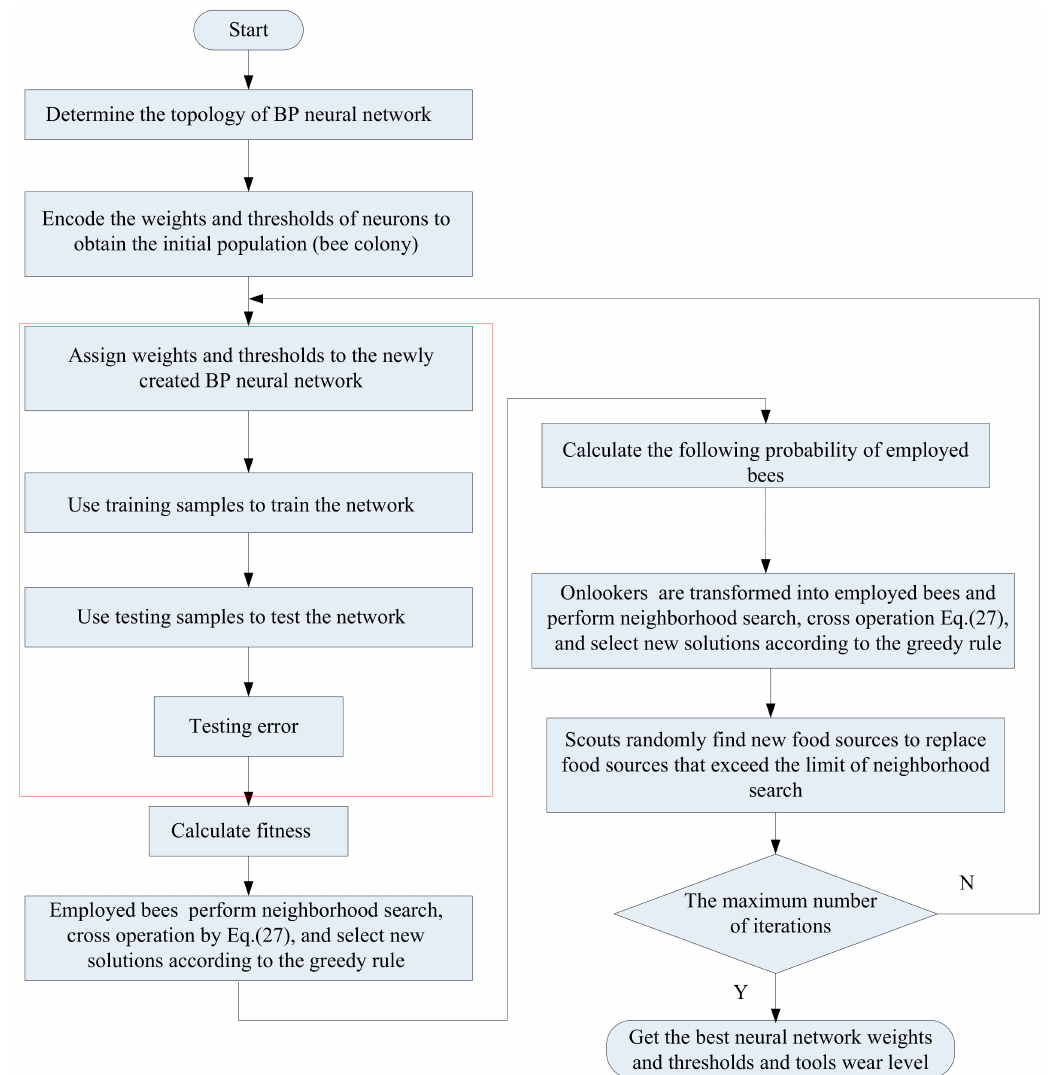
Figure 5. The flowchart of improved artificial bee colony (IABC)-BPNN